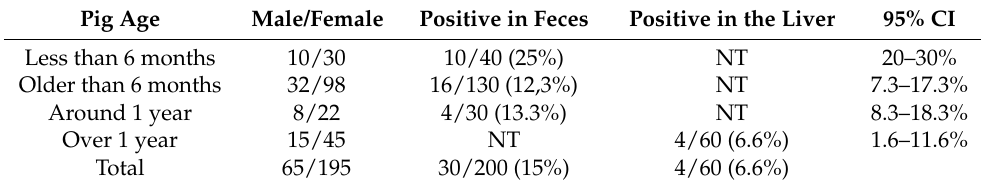
Table 2. Detection of HEV RNA on pig